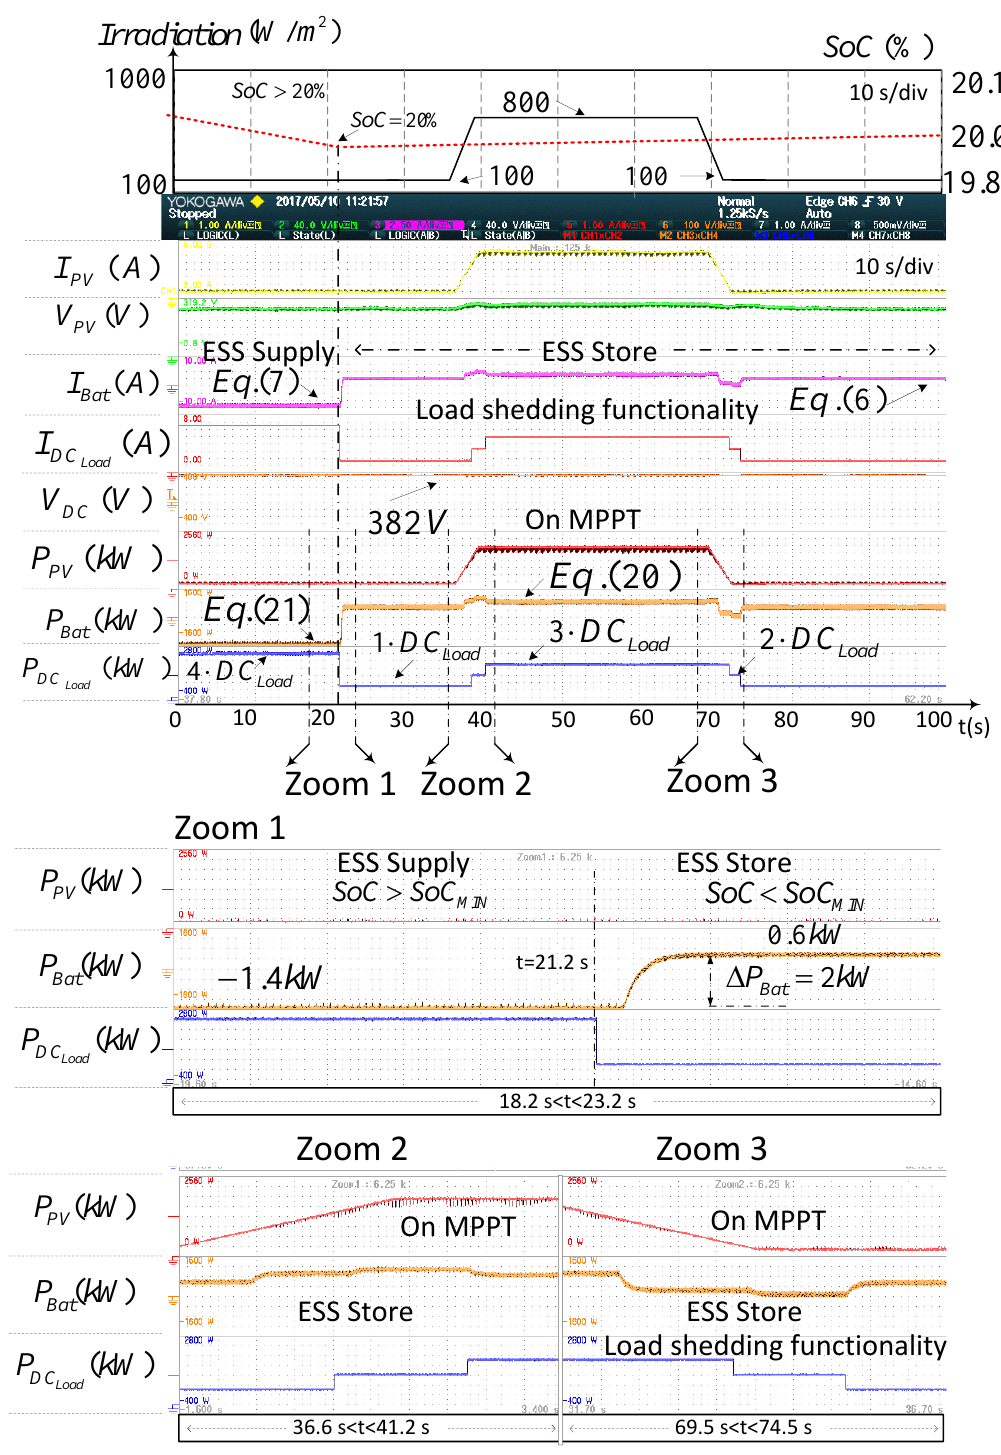
Figure 11. Experiment #3. Evolution of the currents, the power exchange and voltage in the DC microgrid for changes in the SoC .